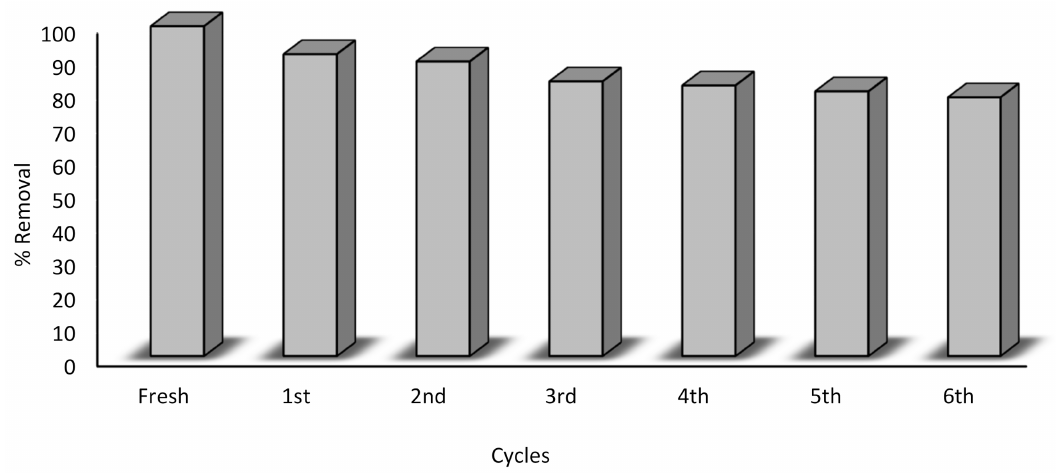
Figure 11. Regeneration of adsorbent and its percentage removal per